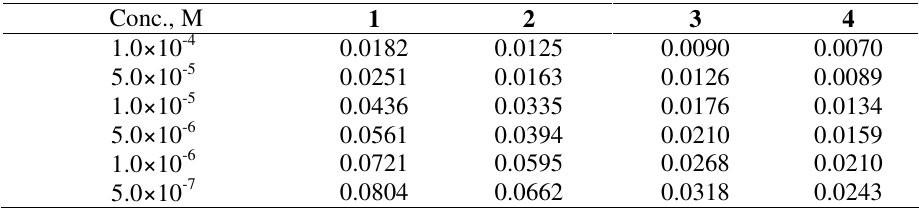
Table 1. Copper weight loss on the presence of varying concentration (M) of organic compounds ( 1-4 ) in 2.0 M HNO for 4.0 3